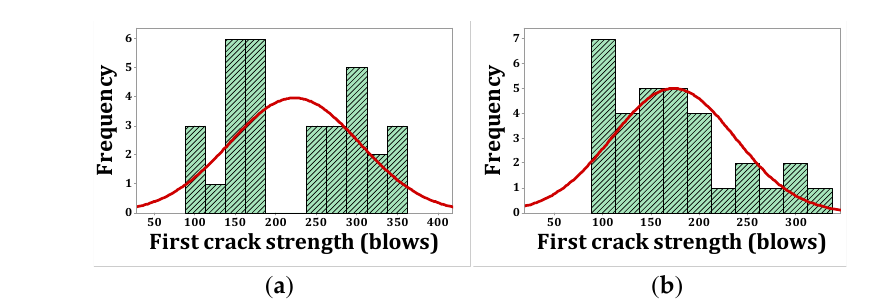
Figure 13. Normal probability plots for first crack (humid): ( a ) R, ( b ) F2, ( c ) F3.